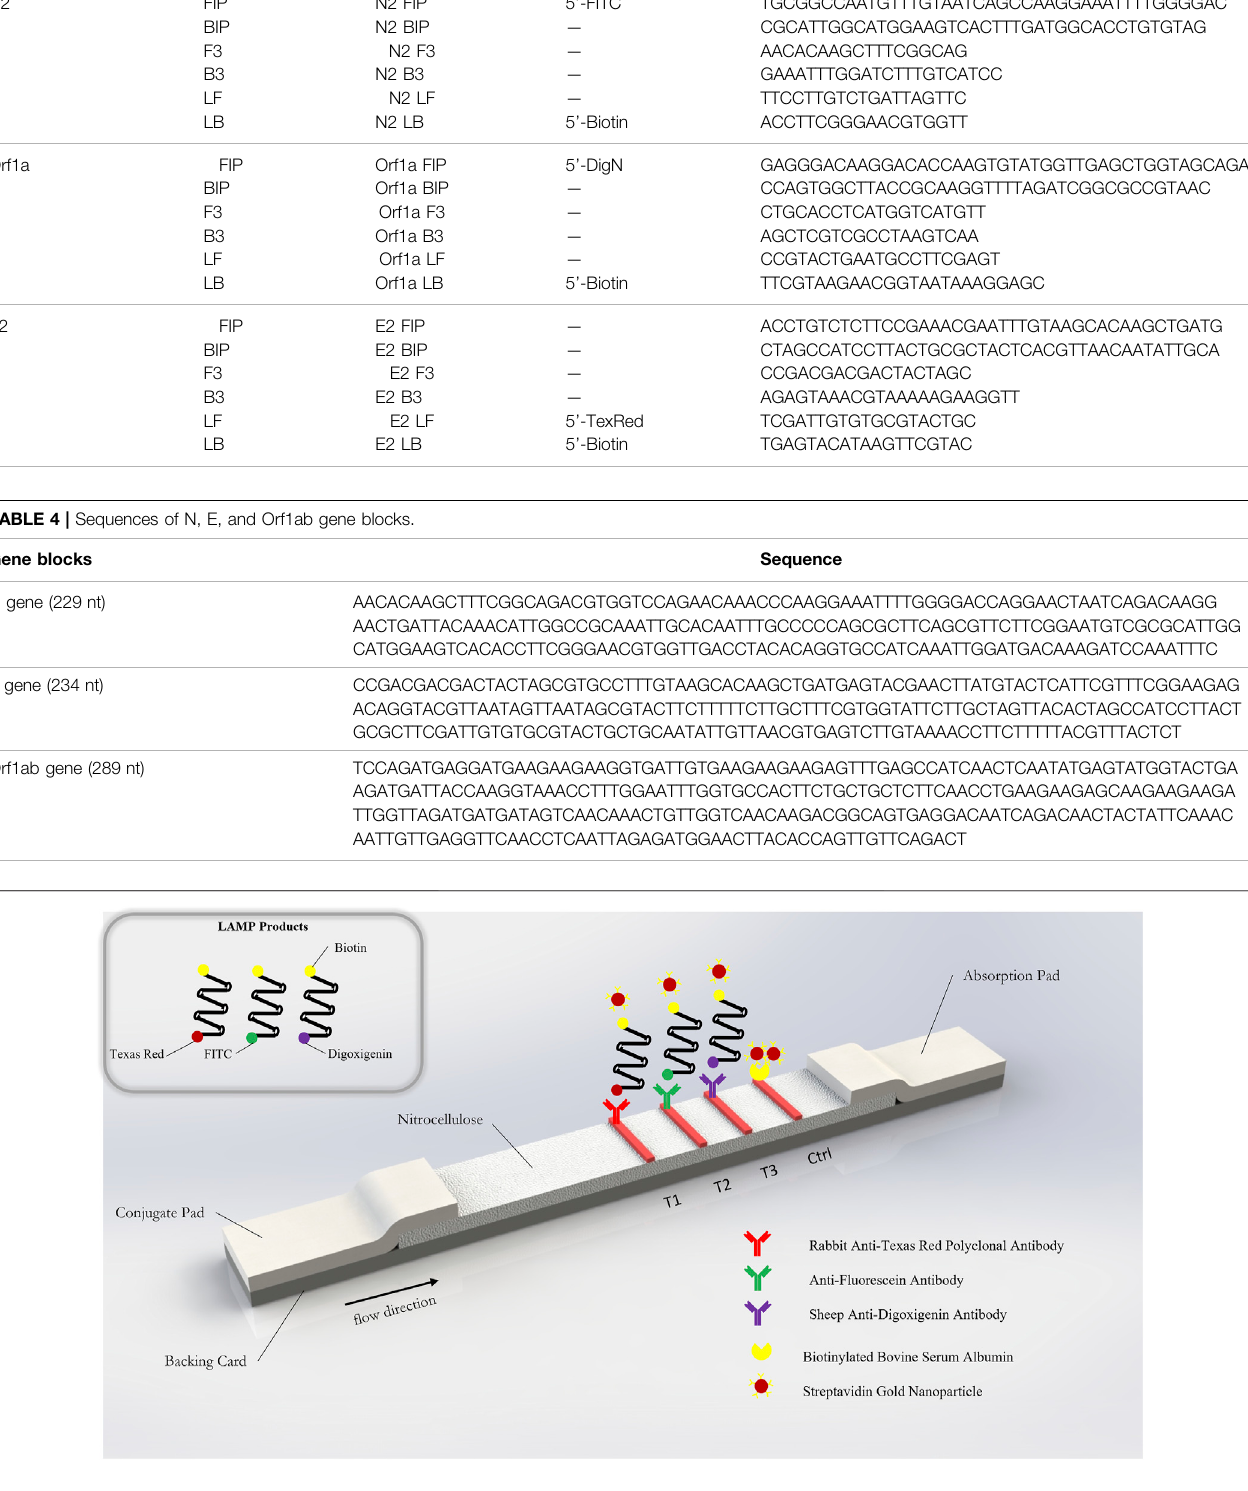
FIGURE 2 | Schematic of gold nanoparticle based lateral fl ow immunosorbent assay for the detection of SARS-CoV-2 Orf1a, N2, and E2 target genes.